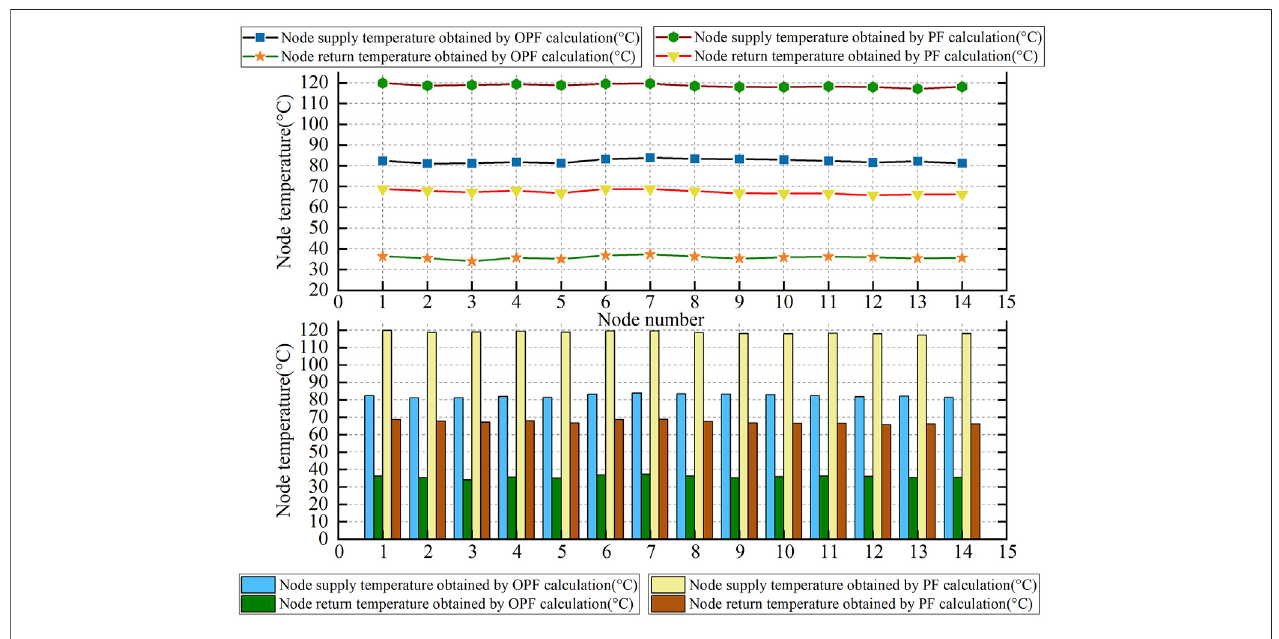
FIGURE 7 | Comparison diagram of the supply and return temperature.